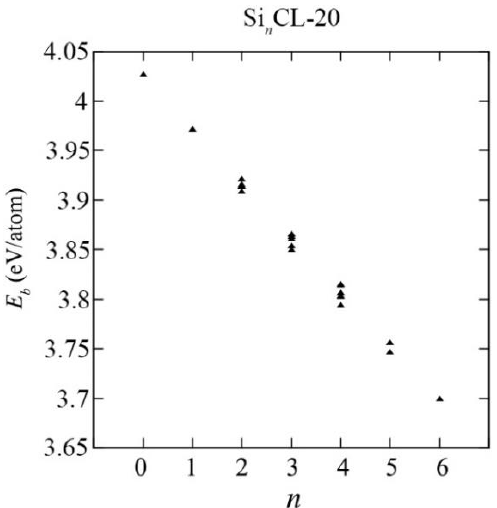
Figure 3. The binding energy versus the number of Si-atoms n in the Si n CL-20 molecule for all possible configurations obtained at the DFT/B3LYP/6-311(d,p) level of theory.